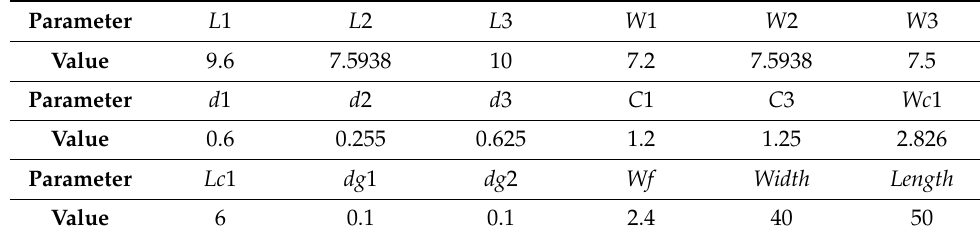
Figure 2. Equivalent circuit model of CSRR and ELC resonant unit. Table 1. Chipless RFID tag size design (unit: mm).